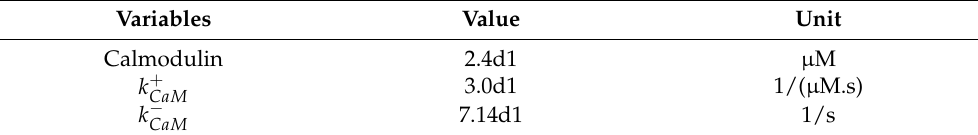
Table 2. Calcium